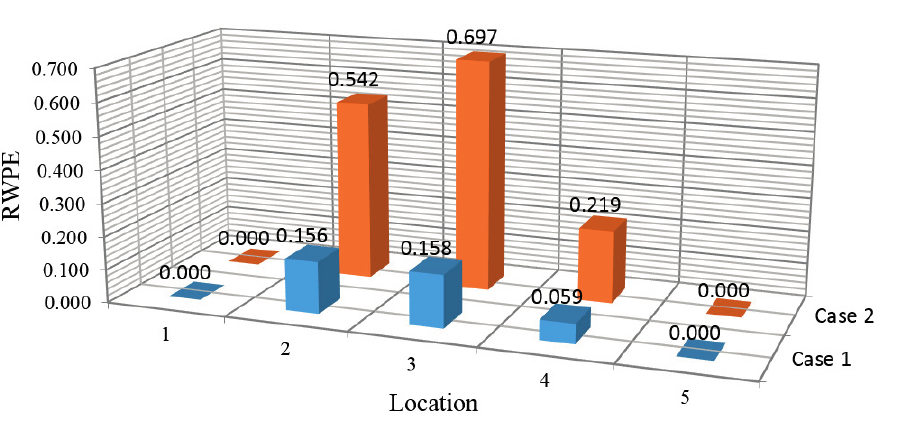
Figure 14. Histogram of RWPEs in two damage